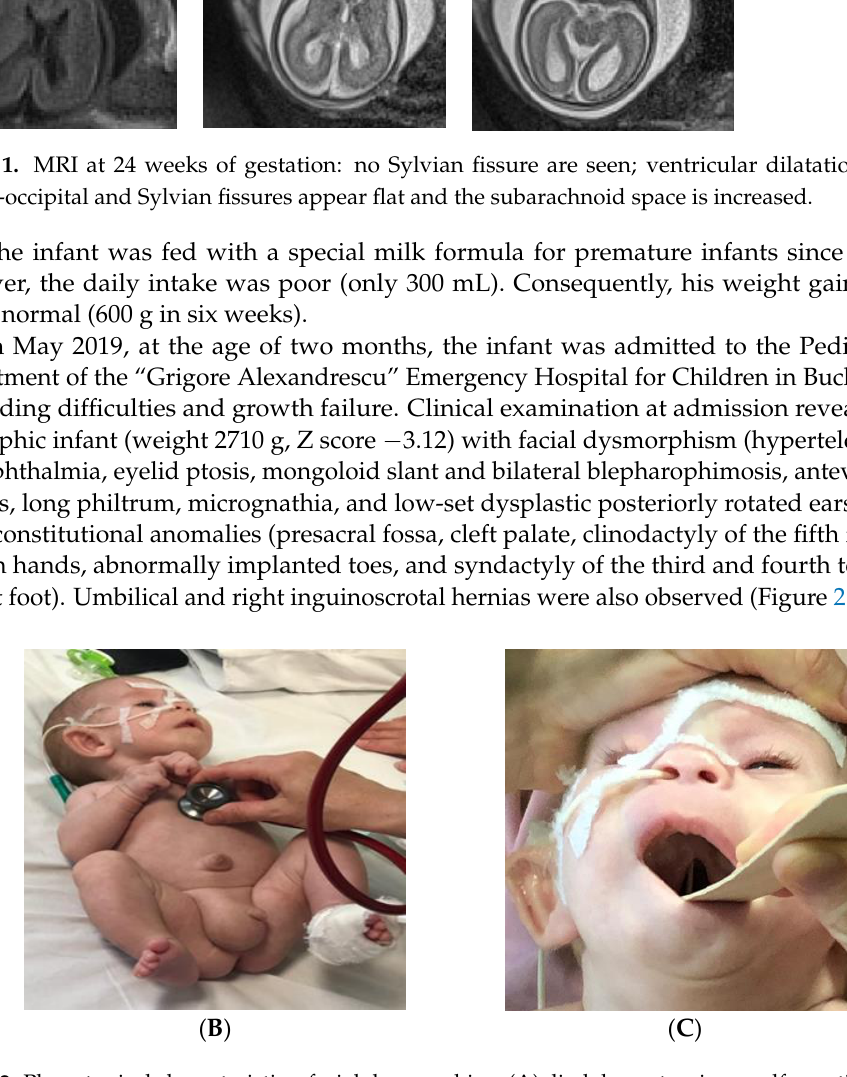
Figure 2. Phenotypical characteristics: facial dysmorphism ( A ), limb hypertension, malformations of the fingers, umbilical and inguinoscrotal hernias ( B ), and partial cleft palate ( C ). Neurologic examination indicated global developmental delay. A cerebral CT scan was conducted and revealed asymmetric lateral ventricles. The cardiological evaluation revealed an atrial septal defect with a small left-to-right shunt without hemodynamic impact. Ophthalmologic examination established the diagnosis of severe bilateral eyelid ptosis that required surgical treatment and hypermetropia that required postoperative optical correction. As indicated by the clinical geneticist, blood samples for microarray testing were obtained. The results were normal, without any significant copy number variations identified.